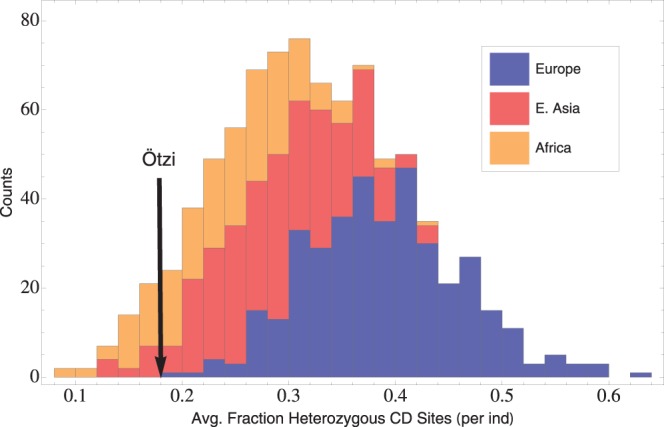
Mean observed heterozygosity across CD GWAS SNPs from 1000 Genomes and Iceman.Histograms represent the distributions of observed average heterozygosities across 49 GWAS SNPs associated with CD in Europeans (Blue), East Asians (Red), Africans (Orange), and the Iceman (black arrow). This figure illustrates that the Iceman’s mean heterozygosity across CD associated loci is low compared to present-day Europeans.